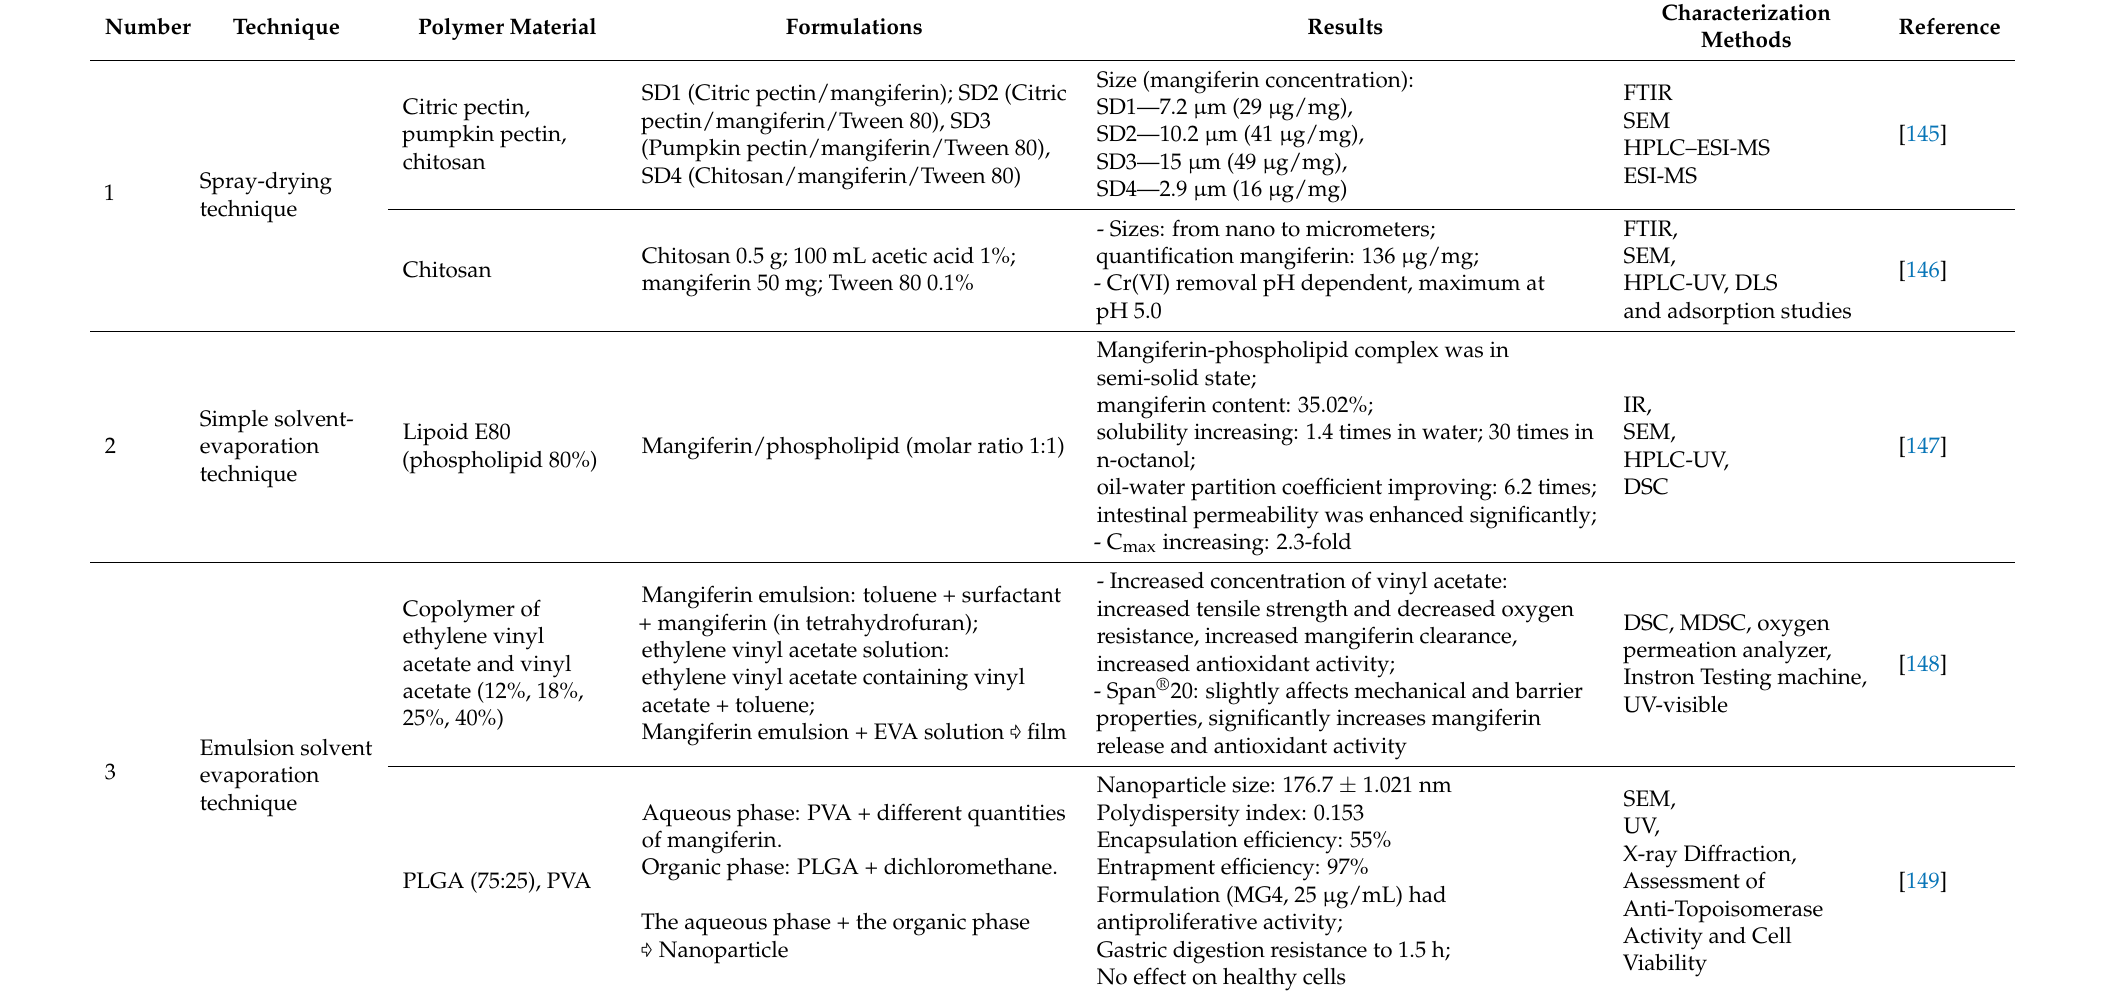
Table 2. Techniques used and the results